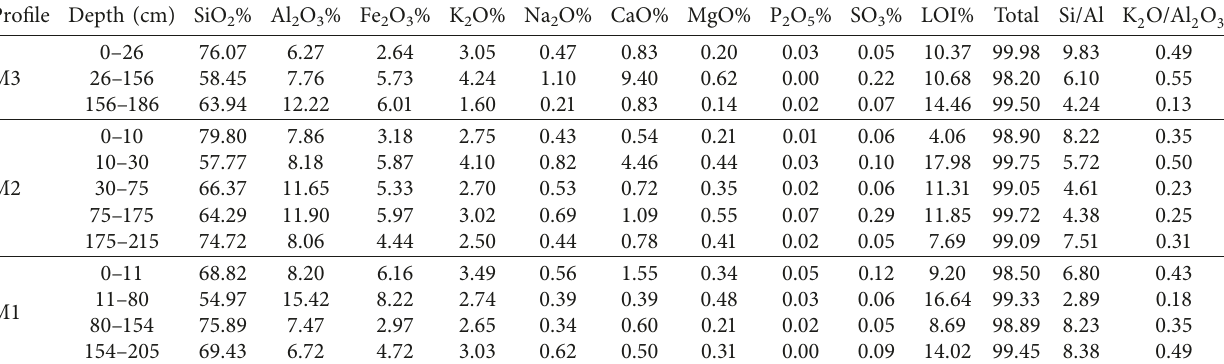
Table 2: Chemical composition of the studied soils.